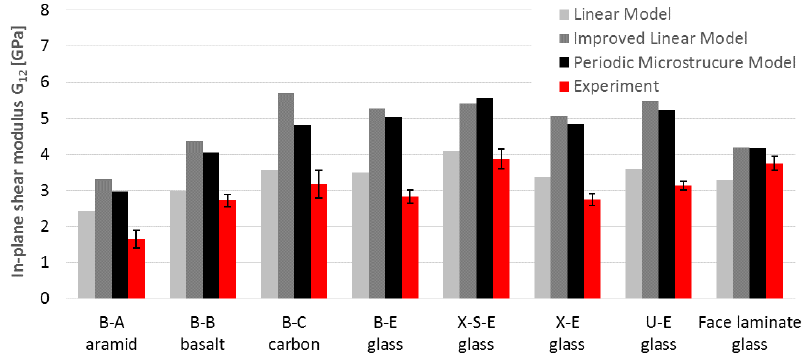
Figure 11. Comparison of in-plane shear modulus G 12 obtained by calculation and experiment.